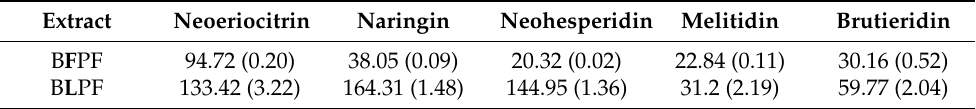
Table 5. Content (mg/g extract) of the major flavonoids present in the extracts expressed as mean (standard deviation).